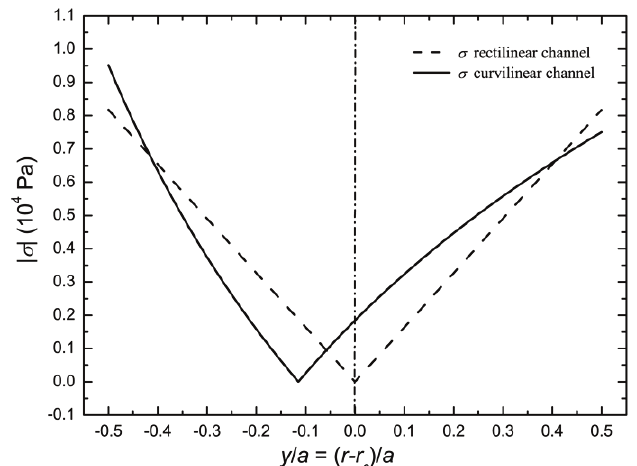
Figure 14. Comparison between the viscous stress as a function of the horizontal coordinate in a rectilinear channel (dashed line), and in a curvilinear channel (solid line). The vertical line indicates the center of the channel r c